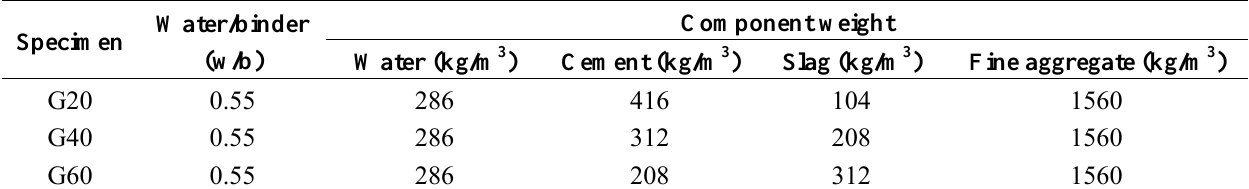
Table 4. Mix design of cement with slag—Type G